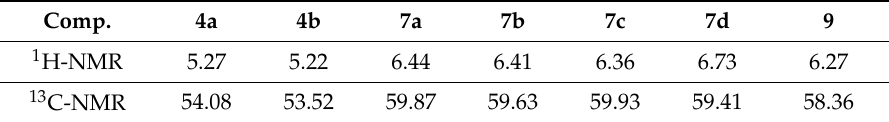
Table 1. 1 H- and 13 C- NMR chemical shifts (δ , in ppm) for the methine proton (C5-H) and carbon (C5) for all compounds discussed in the paper.